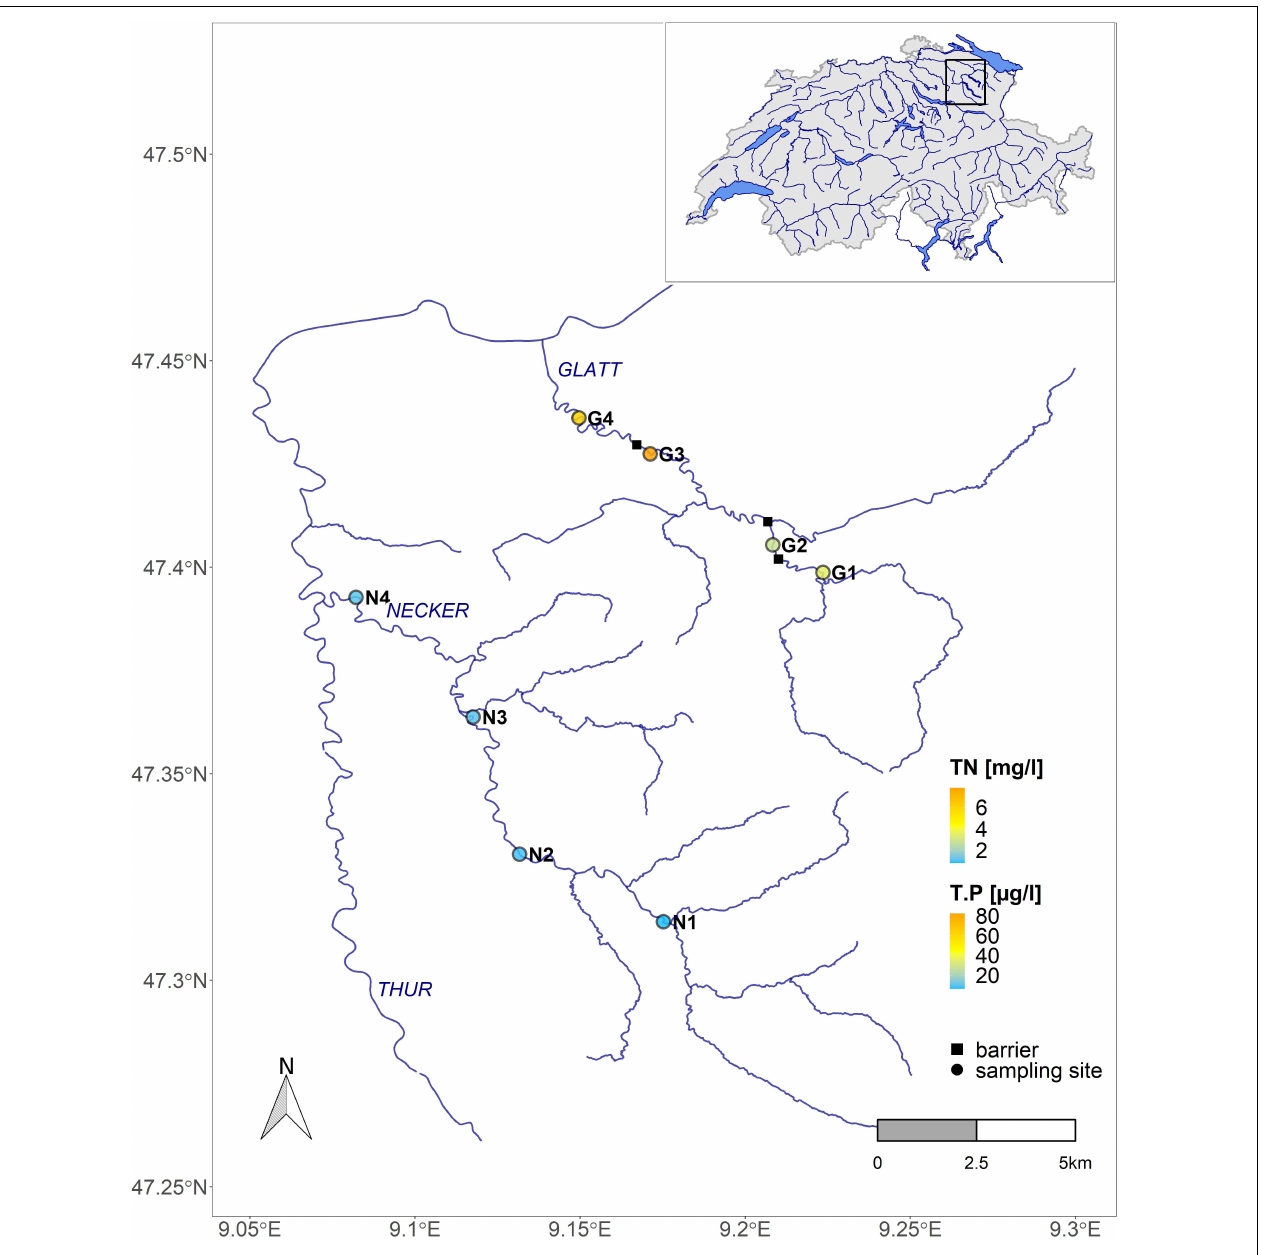
FIGURE 1 | Map of sampling sites on the Necker (N) and Glatt (G) in the Thur catchment, northeast Switzerland (map insert at top right). The color gradient represents nutrient levels (T.P, total Phosphorus; TN, total Nitrogen). Circles represent sampling sites; squares represent major barriers blocking bed